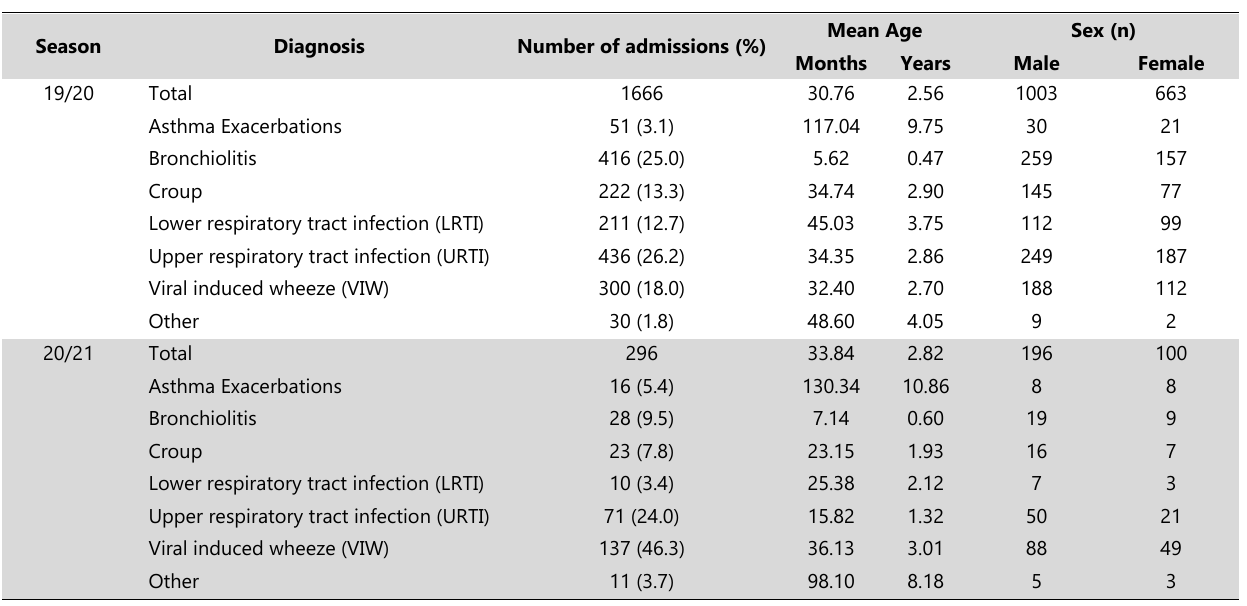
Table 2. Demographics of Children and Young People Presenting to ED with Respiratory Illness.